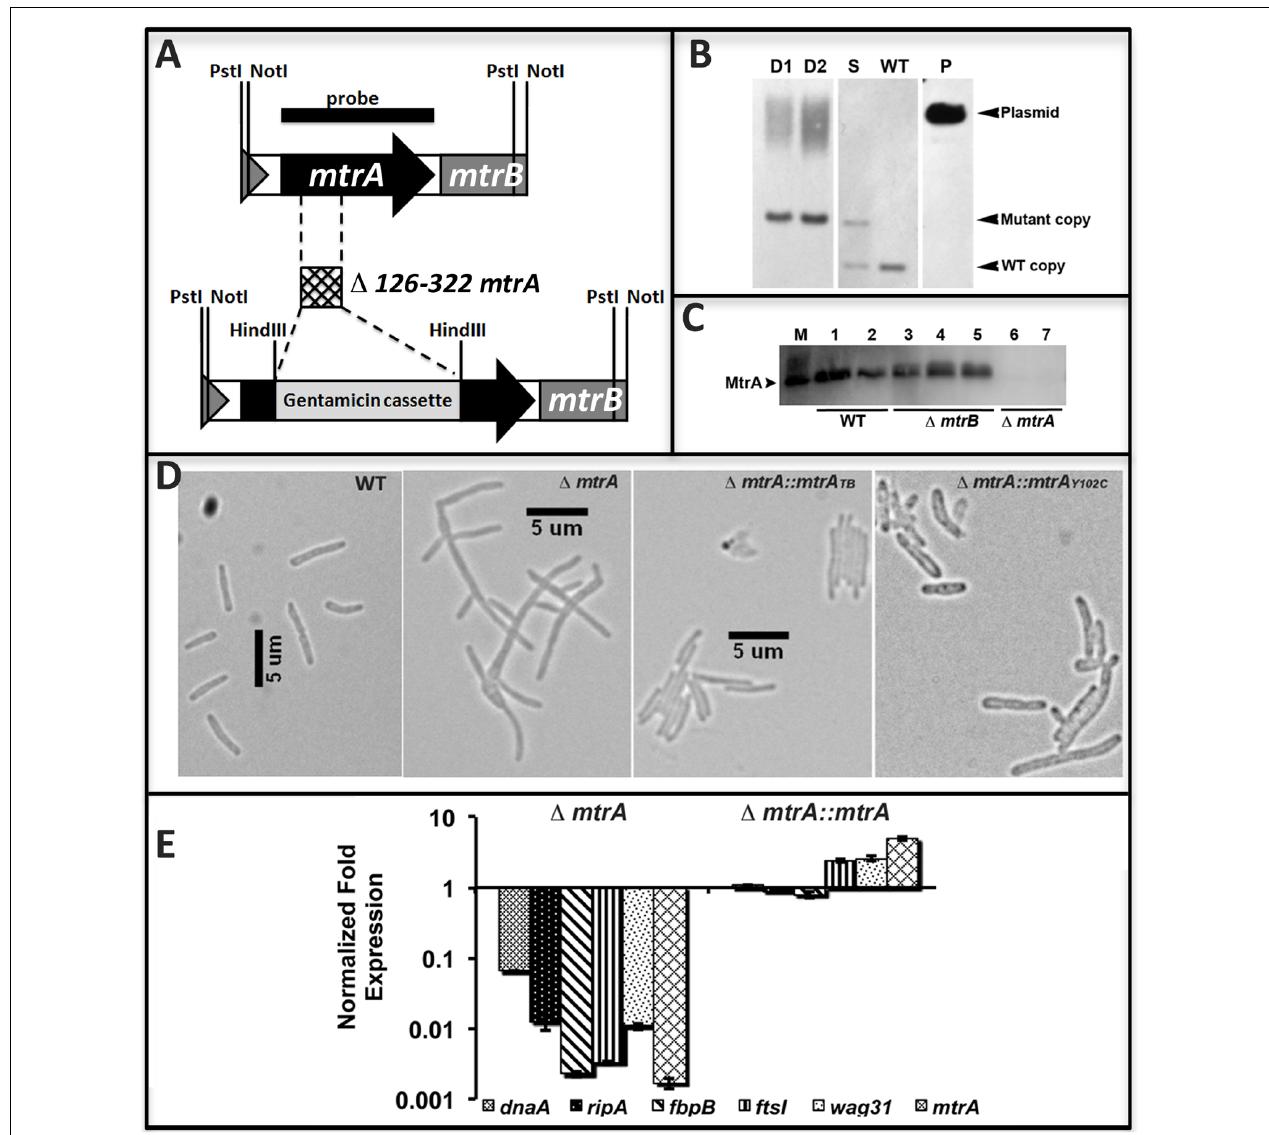
FIGURE 5 | Construction and characterization of M. smegmatis mtrA mutant. (A) Schematic of mtrAB region showing the deletion of nucleotides 126–322 followed by insertion of gentamicin cassette in the mtrA coding region. (B) Southern blot confirming the deletion of mtr A. Genomic DNA was isolated from WT M. smegmatis , one single-crossover (S) and two double-crossovers (D1 and D2), digested with Not I, transferred to Hybond-N + membrane (GE Healthcare) and probed with mtr A fragment (black bar in A ). Bands corresponding to the WT (1306-bp) and mutant (1921-bp) copy were seen in single crossover and those corresponding to WT only or mutant only copy were seen in WT and double crossover strains, respectively. Size of mutant band includes 851-bp gentamicin cassette. (C) The loss of MtrA in (cid:49) mtrA strain was confirmed by immunoblotting with MtrA antibodies. (D) Loss of MtrA leads to filamentation and cell shape defects. Exponential cultures of M. smegmatis WT, (cid:49) mtrA , (cid:49) mtrA Pami::mtrA, and (cid:49) mtrA Pami::mtrA Y102C were examined by bright field microscopy and imaged as described in the text. (E) qRT analysis of MtrA targets. Expression levels of select genes was measured, normalized to sigA and data presented as fold expression relative to the WT strain.